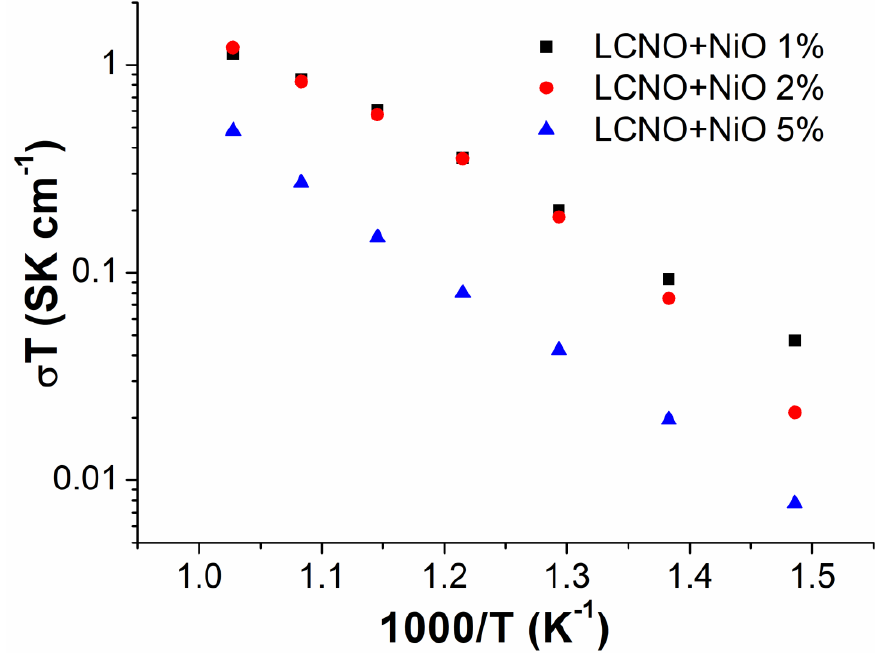
Figure 7. The conductivity of 1, 2 and 5 wt.% NiO-doped LCNO electrolyte. The lattice parameters of pure LCNO; 1% external doping; and 1%, 2% and 5% internal doping samples were calculated as 332.884, 333.260, 332.782, 332.845, 333.167 Å 3 , respectively. Rietveld refined XRD patterns are also shown in Figure 8. The lattice volume would be expected to decrease if Ni replaced Nb and was completely doped into the lattice, as the ionic radius of Ni 2+ (60 pm) is smaller than that of Nb 5+ (64 pm) [24,25]. When the 1% is applied with the internal method, the expected decrease in lattice volume is observed. However, the lattice volume increases from 1% to 2%, although the lattice vol- ume of the 2% sample is still smaller than that of the undoped LCNO, implying that Ni is